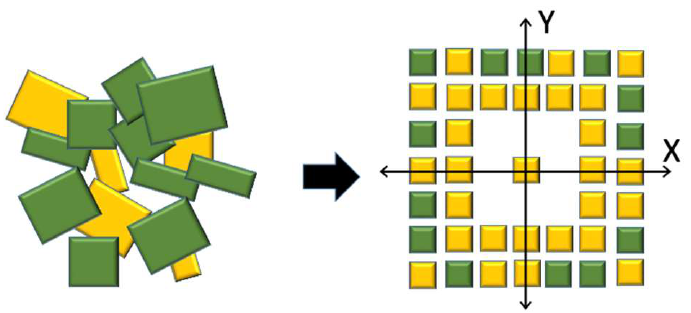
Figure 1. Concept of patterning approach for polymorph separation: Left, polymorph agglomerates; Right, separated addressable structures made by a single polymorph. The geometry reproduces an Aztec code in which the central point is the finder pattern of the code.